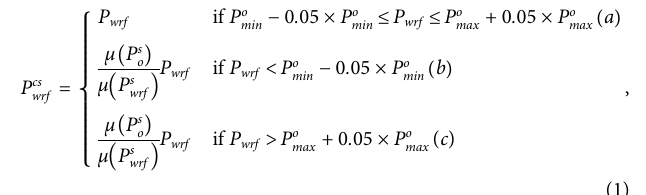
( Figure 1 ). We eliminated stations with more than 30% monthly